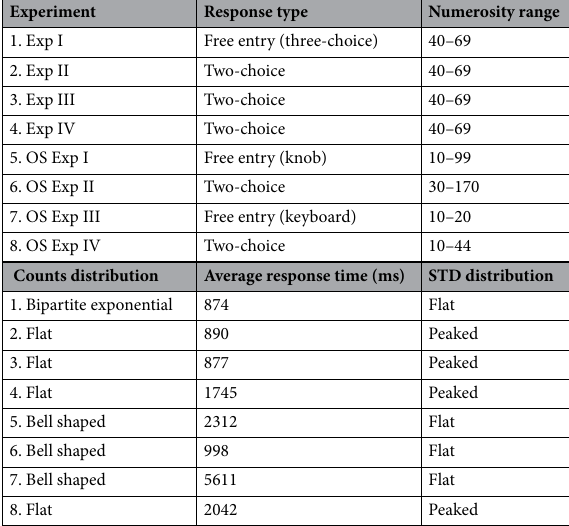
Table 1. Main differences in the methods of the eight